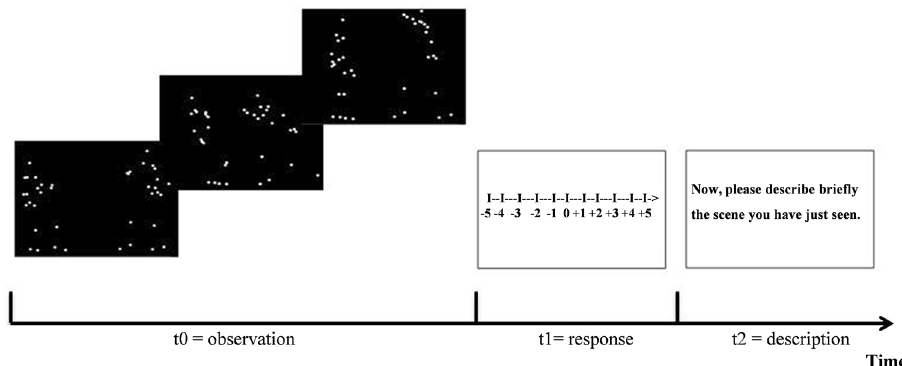
Figure 2. Experimental paradigm: valence judgments of emotional body movements, using the technique “Point-Light displays”. t0 = 3-s silent movies depicting whole-body movements presented with PLD; t1 = valence judgment task; t2 = description